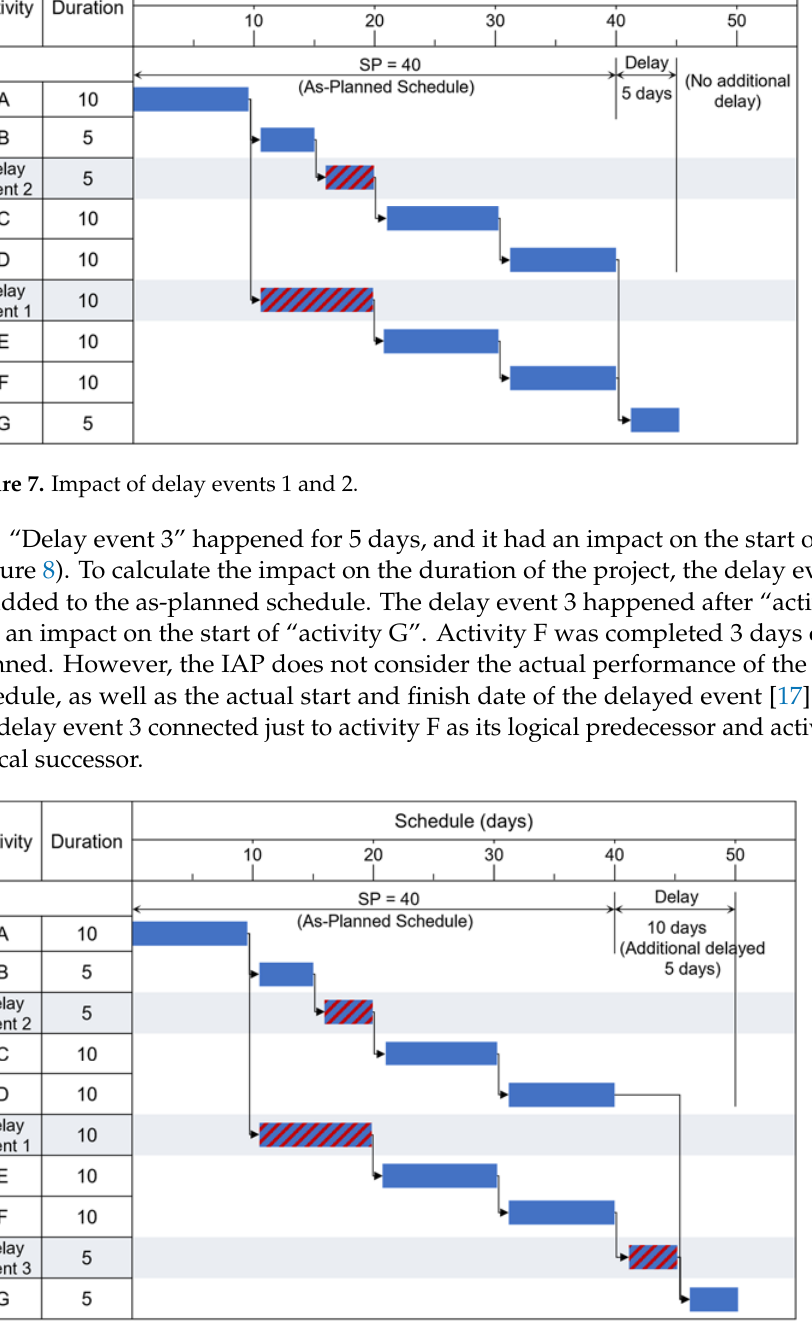
Figure 9. Adding delay event 1 by constraints.